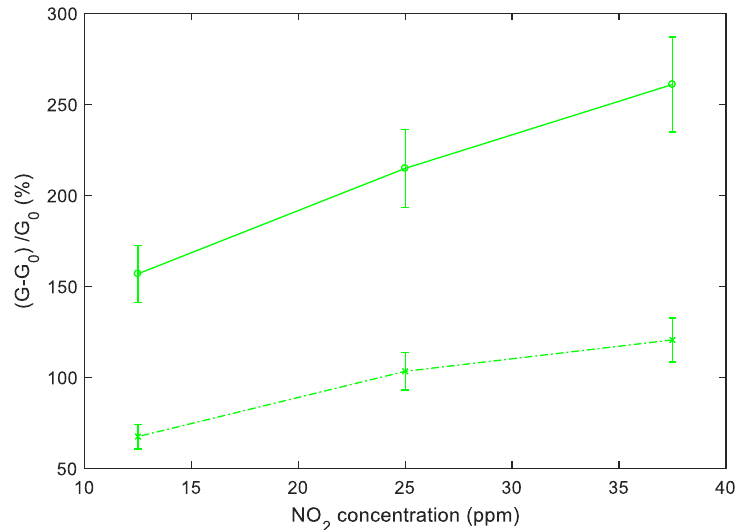
Figure 13. TiO 2 -decorated sensor response to NO 2 as a function of the NO 2 concentration using the temperature profile shown in Figure 8. Dashed line: Response sampled at the end of the last T high pulse of each NO 2 injection, solid line: Response sampled at the end of the last T low pulse of each NO 2 injection; the error bars refer to the estimated repeatability (approximately 10% of the response value).